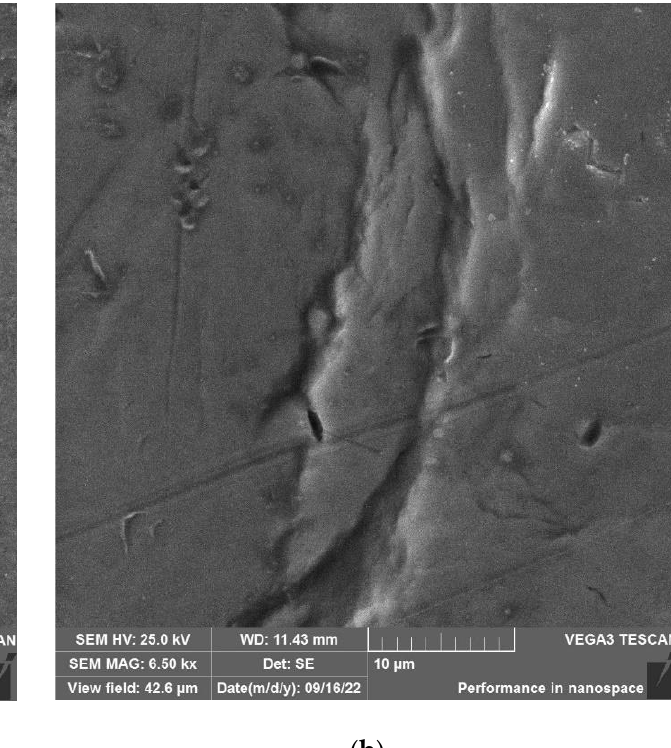
Table 6. The values t, σ Y , A, n, E, and ν used for FEM calculations at T = 20 °C.